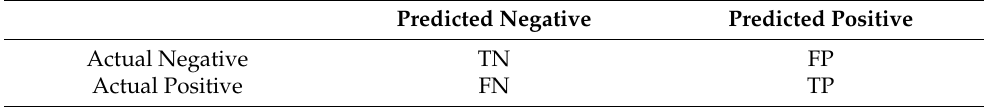
Table 3. Confusion